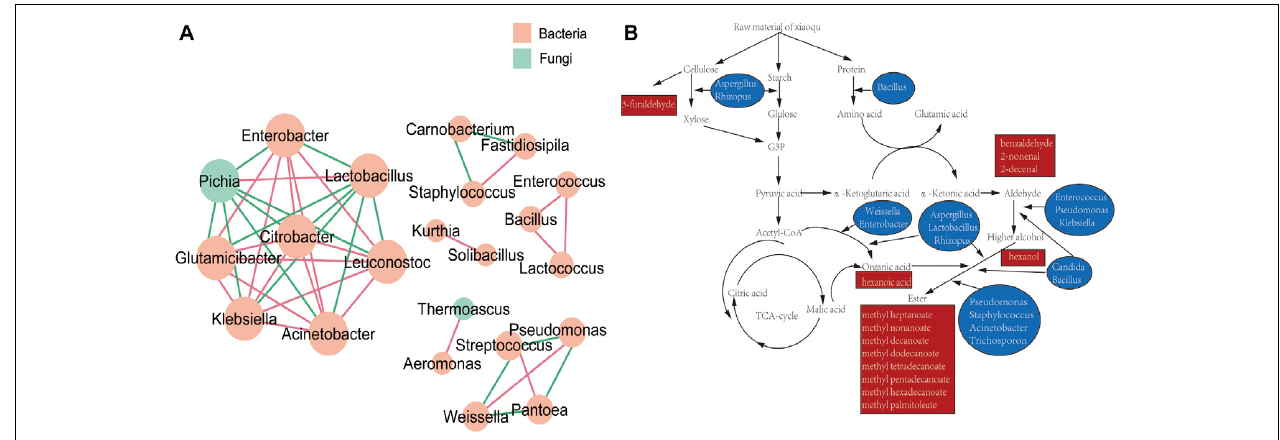
FIGURE 6 | (A) Association network diagram of dominant genera. (B) Metabolic map of dominant genera in Xiaoqu .